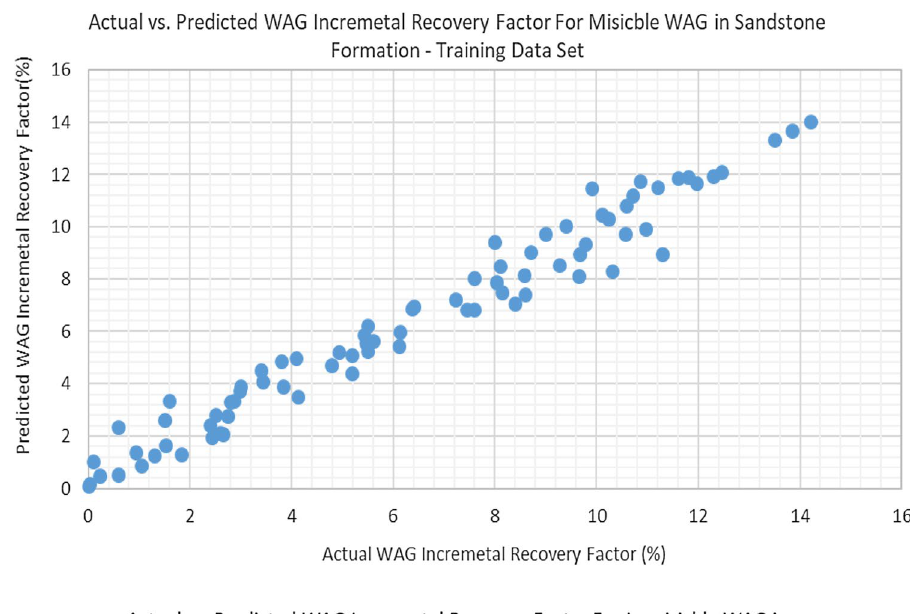
Fig. 15 GMDH WAG incre- mental recovery factor predic- tion model training results for immiscible WAG in sandstone